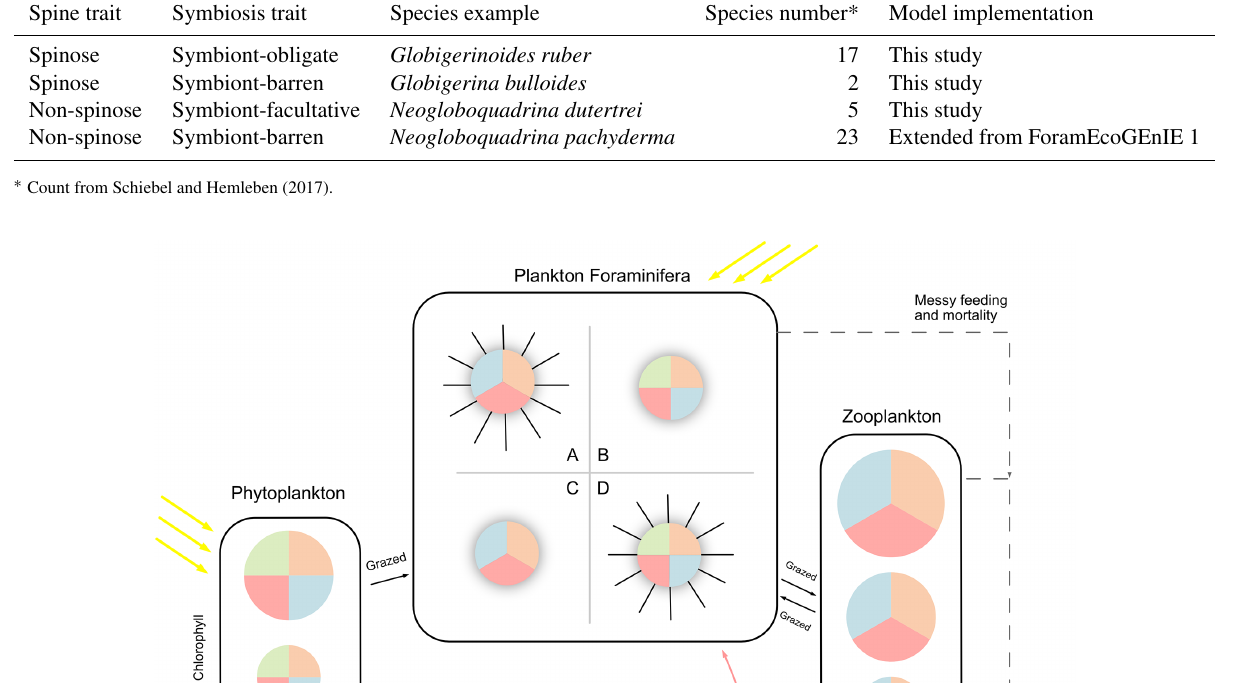
Table 1. The four modelled functional groups of planktic foraminifera and their species representative in ForamEcoGEnIE 2.0. Spine trait